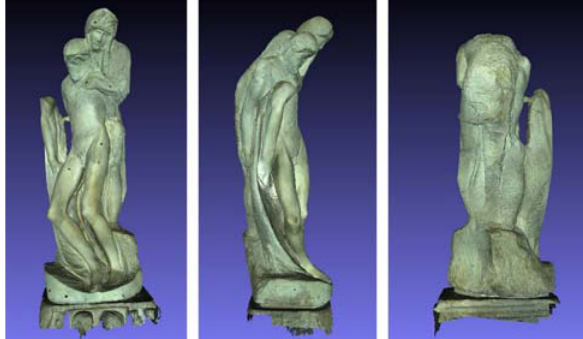
Figure 4. Final coloured mesh composed of 21 million triangles, with a certified resolution of 0,2